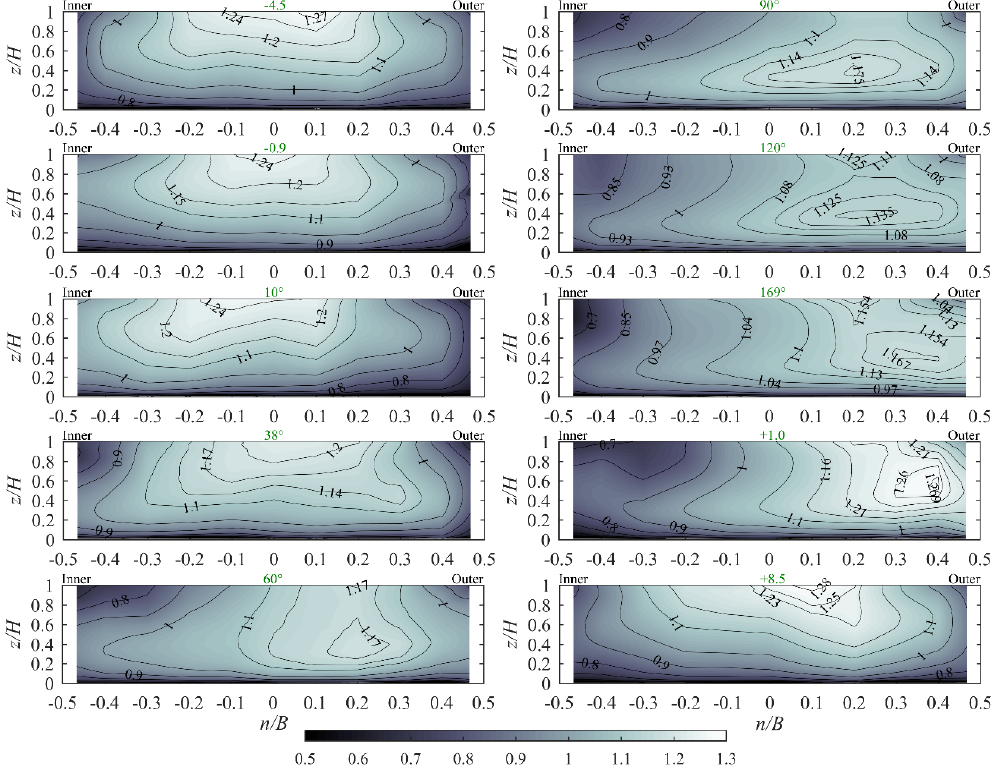
Figure 3. Stream-wise velocity distribution at ten cross-sections ( − 4.5, − 0.9, 10°, 38°, 60°, 90°, 120°, 169°, +1.0, +8.5).